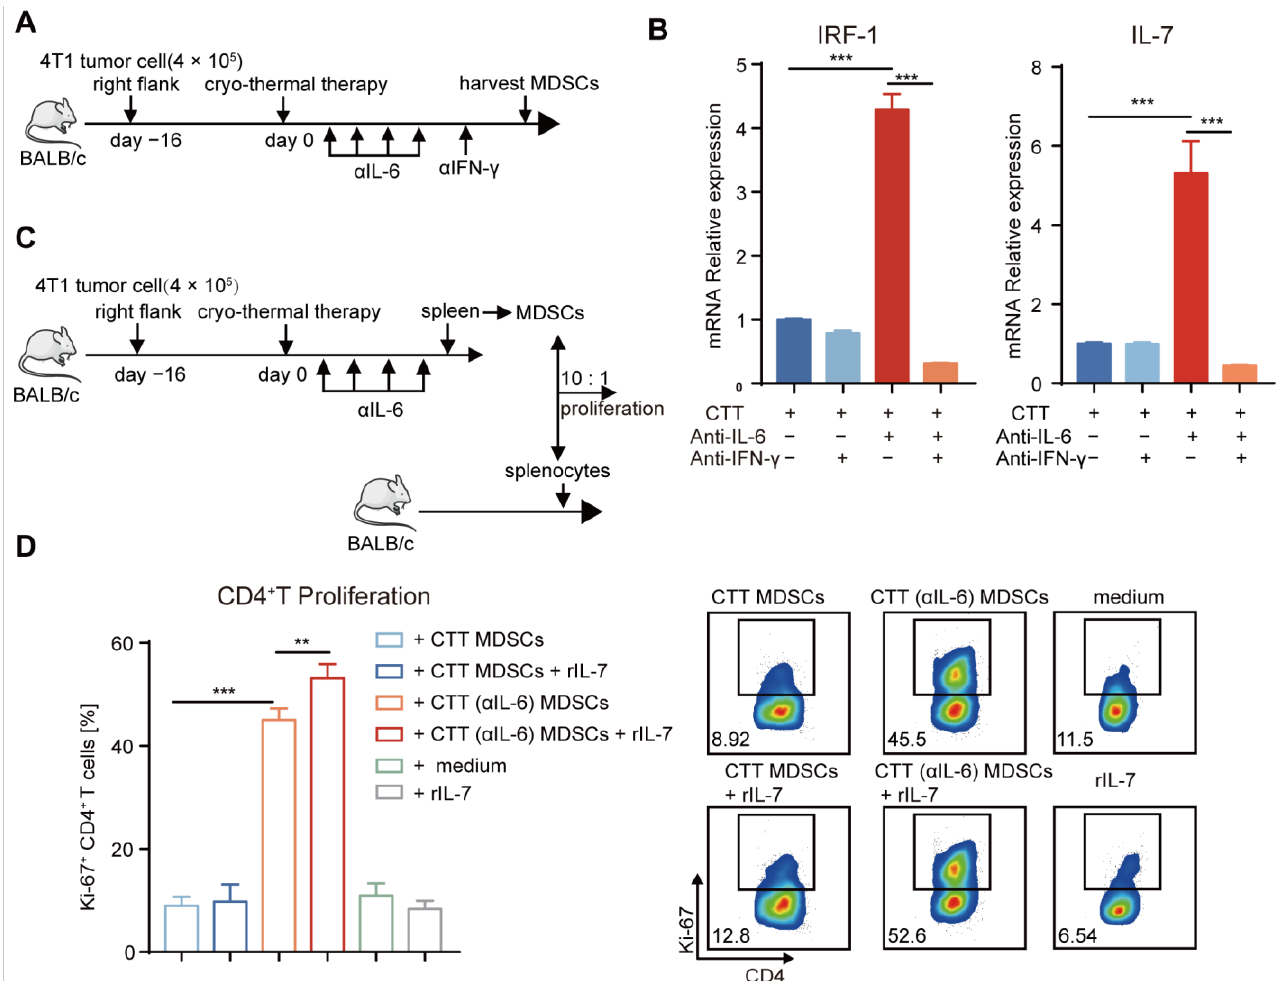
Figure 7. Mature MDSCs after combination therapy promoted the proliferation of CD4 + T, which was mediated in part by the IFN-γ/IRF-1/IL-7 axis. ( A ) Experiment schematic: 1 day after combination therapy, mice were treated with anti-IFN-γ (250 μg) and MDSCs were harvested by MACS on Day 21. ( B ) The mRNA level of IRF1 and IL-7 was measured by qRT-PCR. ( C ) T cell proliferation assay: splenic MDSCs from different groups were separated by MACS, and then they were co-cultured with splenocytes from age-paired naïve BALB/c mice in ratio of 10: 1 with rIL-7(10 ng/mL) or PBS. ( D ) The expression of Ki-67 in CD4 + T cells. n = 4 for each group. ** p < 0.01, *** p < 0.001. Data were analyzed using one-way ANOVA. C, tumor-bearing control; CTT, cryo-thermal therapy.